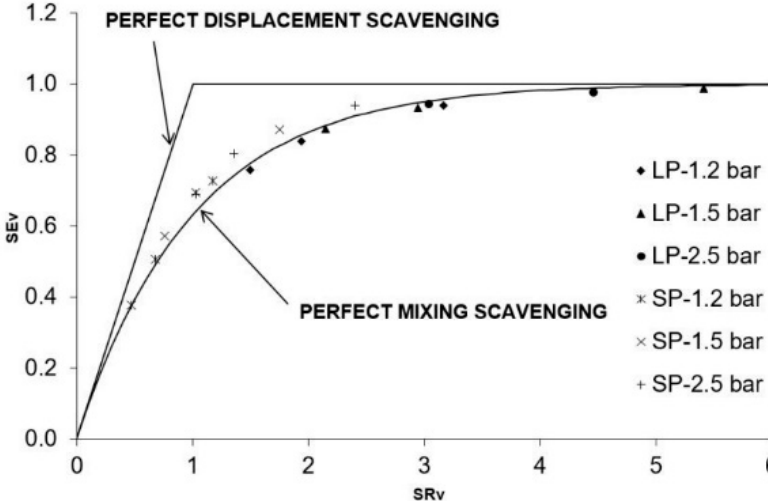
Figure 14. Volumetric scavenging ratio ( SR v ) and efficiency ( SE v ) characteristics of model calculation.